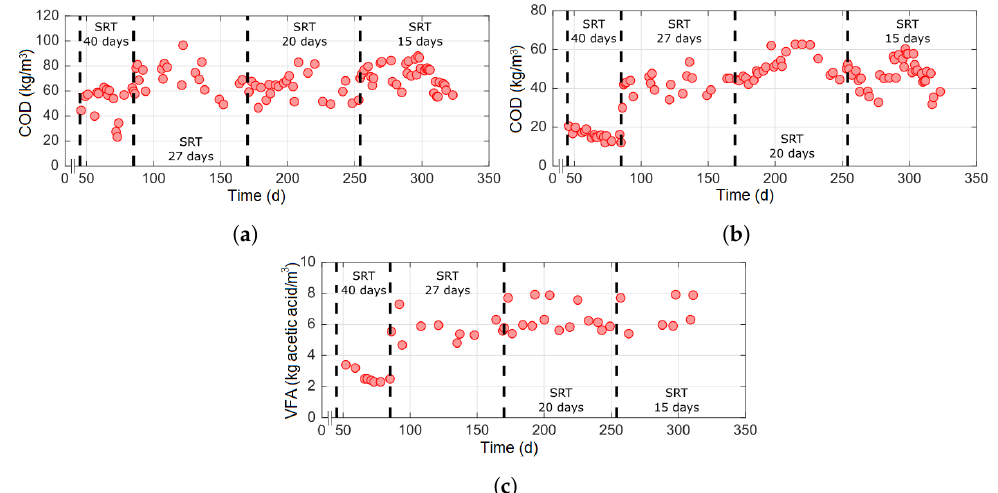
Figure 1. Time-course of ( a ) chemical oxygen demand concentration on the influent (kg/m 3 ); ( b ) chemical oxygen demand concentration on the effluent (kg/m 3 ). ( c ) total volatile fatty acids on the effluent (kg acetic acid/m 3 ).